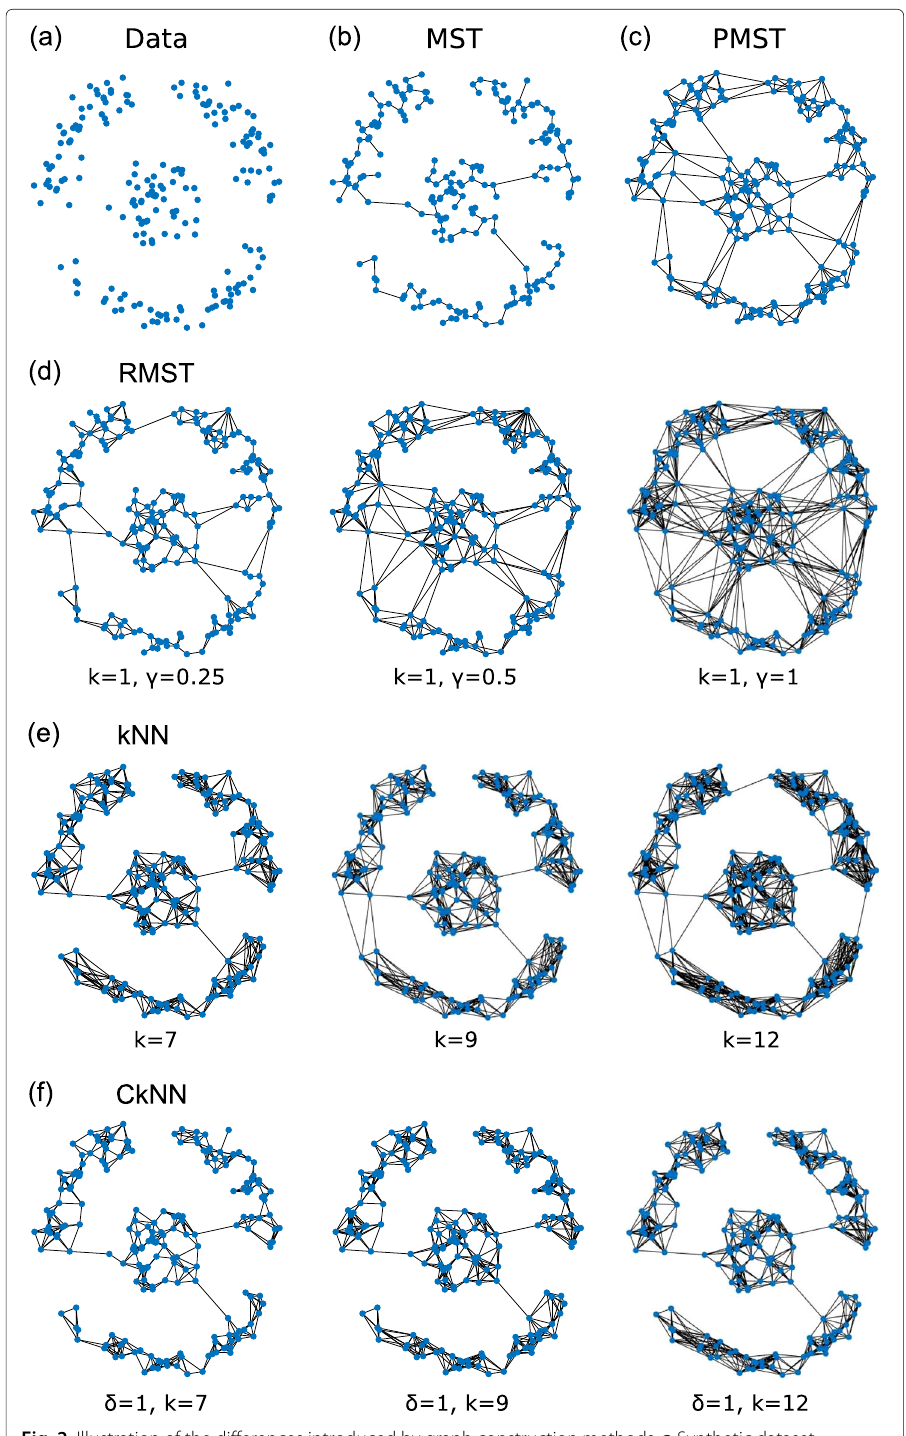
Fig. 2 Illustration of the differences introduced by graph construction methods. a Synthetic dataset consisting of four groups of randomly sampled points: three groups are sampled from a circle and one group from its centre. b The minimum spanning tree (MST) of the dataset based on Euclidean distances. We also present the graphs constructed with MST-based methods: c PMST and d RMST, as well as neighbourhood methods: e kNN and f CkNN. RMST, kNN and CkNN are shown for different parameters that vary the sparsity of the resulting